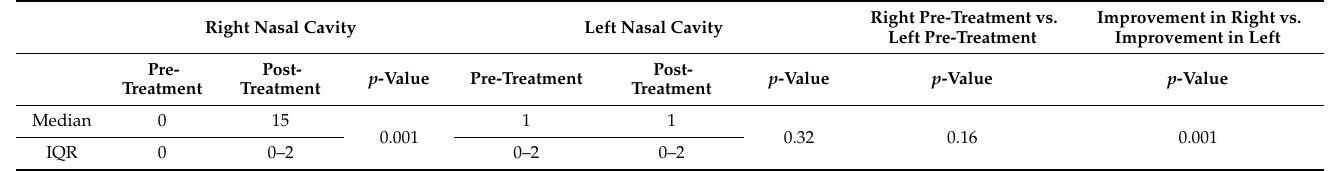
Table 6. The median and interquartile range of glandular hypertrophy—a pathological feature—pre- and post-treatment compared between the right (test) and left (control) sides. Left Nasal Cavity Right Pre-Treatment vs. Left Pre-Treatment Improvement in Right vs. Improvement in